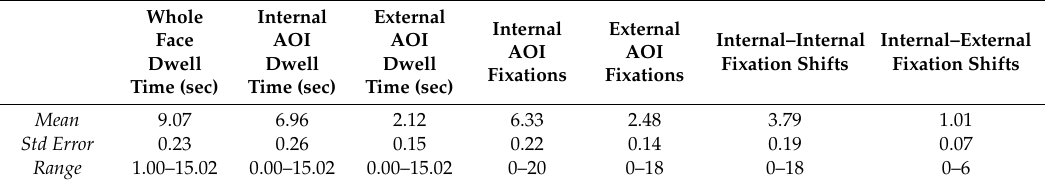
Table 2. Infant looking behavior during the familiarization video.